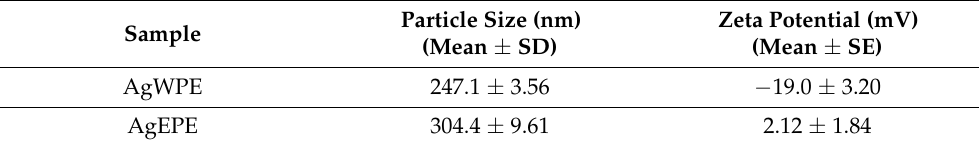
Table 3. Size distribution and zeta potential of AgNPs prepared using aqueous (WPE) or ethanolic (EPE)